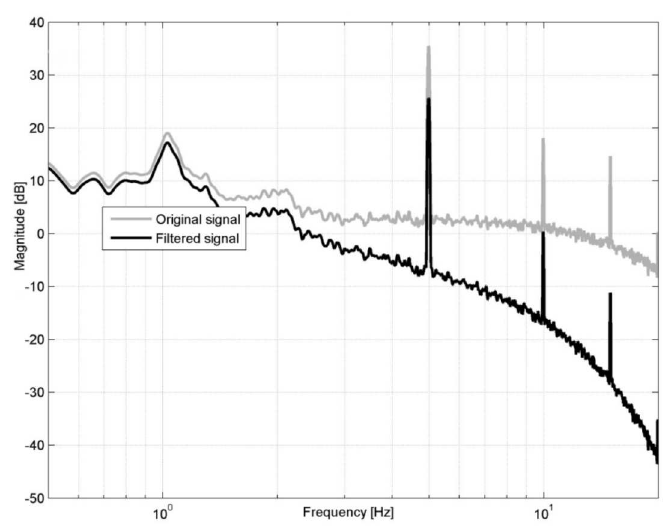
Figure 3. Spectral analysis in the C3 point (sample